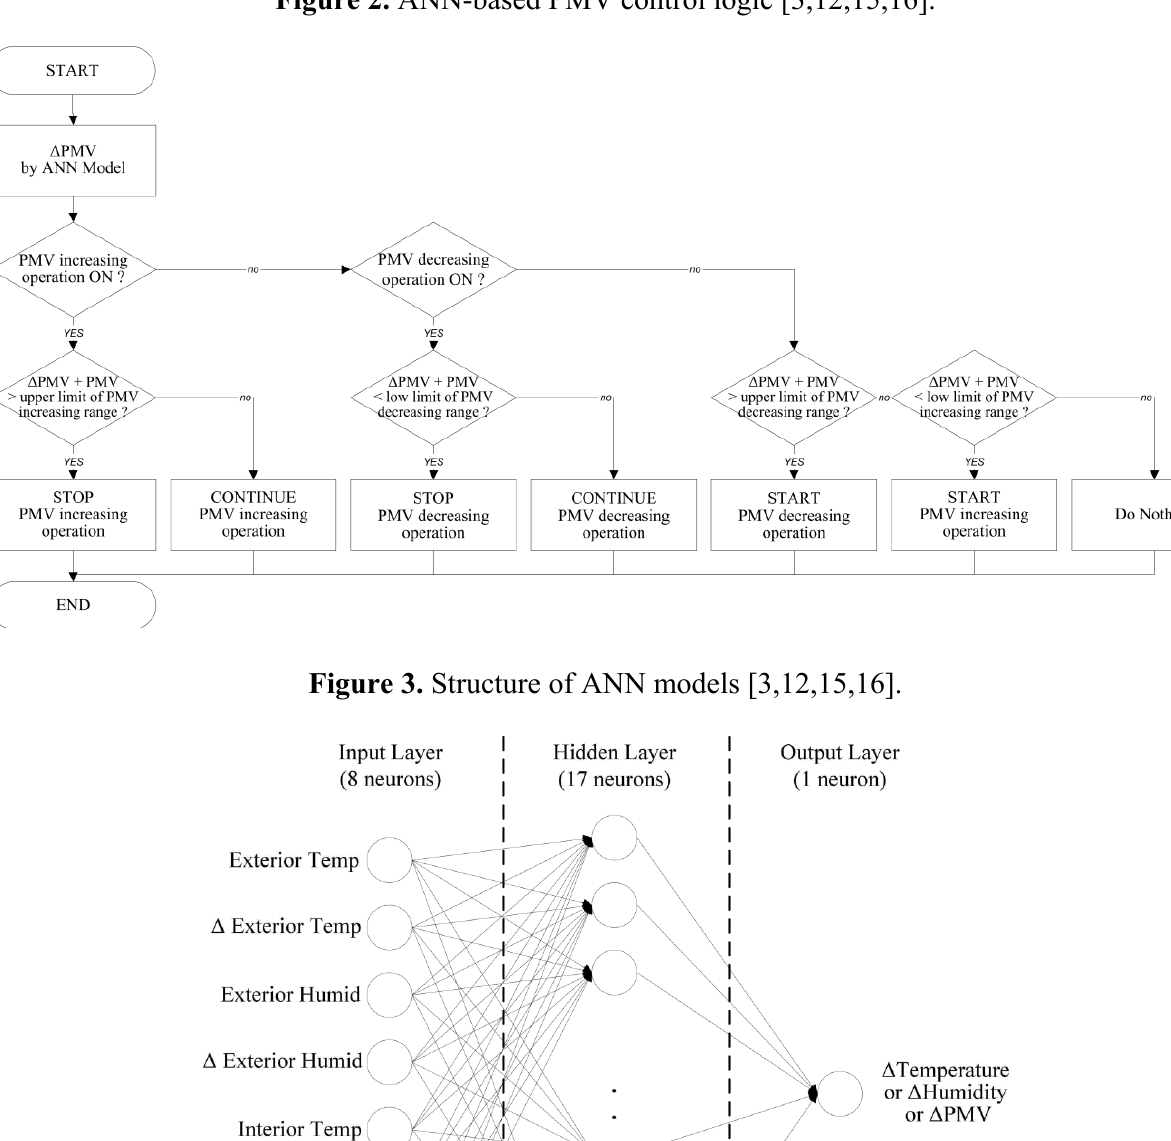
Figure 2. ANN-based PMV control logic [3,12,15,16].